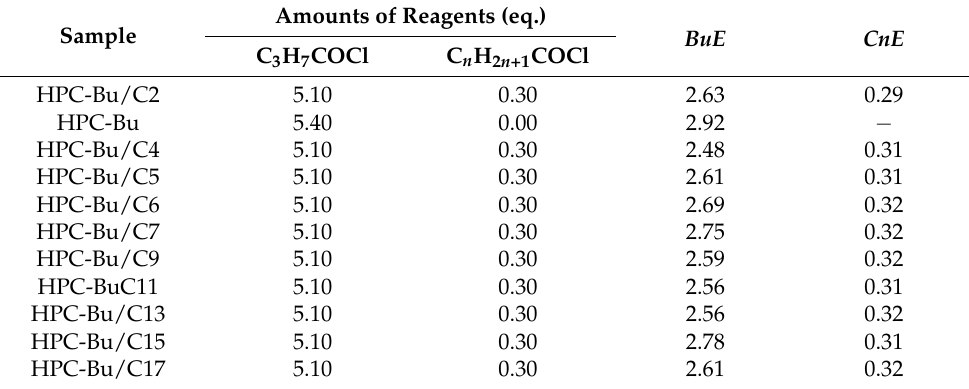
Table 2. Feed amounts of alkanoyl chlorides used in the syntheses of HPC-Bu/C n , and the number of the hydroxy groups substituted by C 3 H 7 COCl and C n H 2 n +1 COCl per anhydroglucose unit, denoted as BuE or CnE , respectively, determined by 1 H-NMR spectra. The amounts of reagents are expressed in the unit of equivalents relative to the number of anhydroglucose units in 2.00 g of HPC. Amounts of Reagents (eq.) Sample